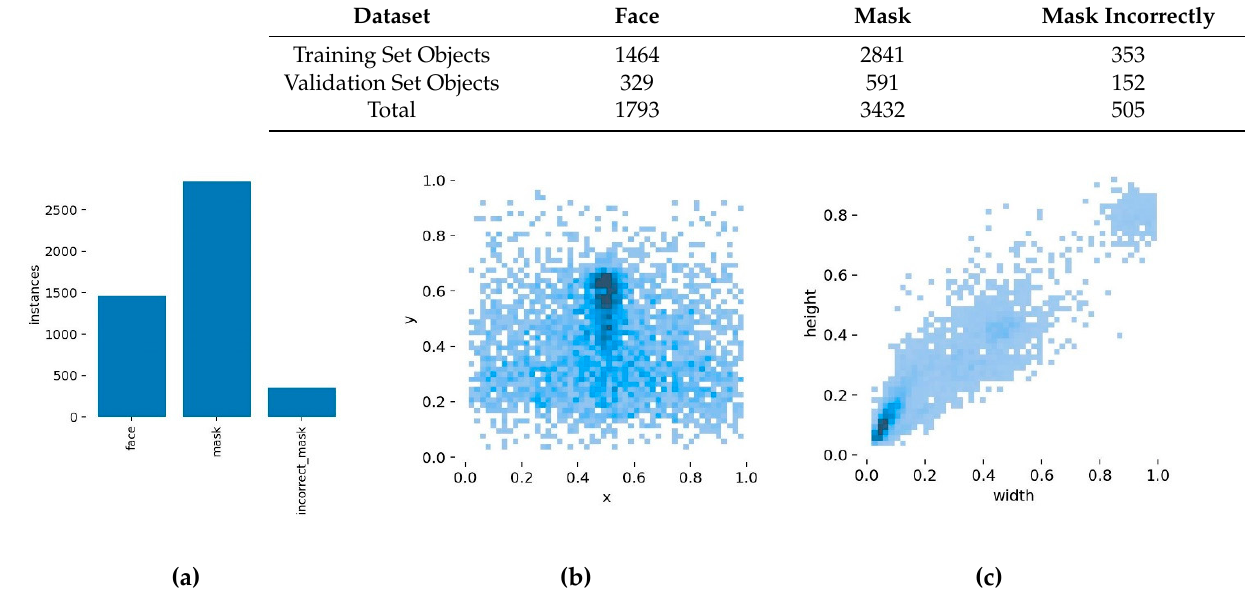
Figure 11. The visualization results of the analysis of the dataset. ( a ) The distribution of object categories in the dataset; ( b ) the distribution of object centroid locations; ( c ) the distribution of object sizes.